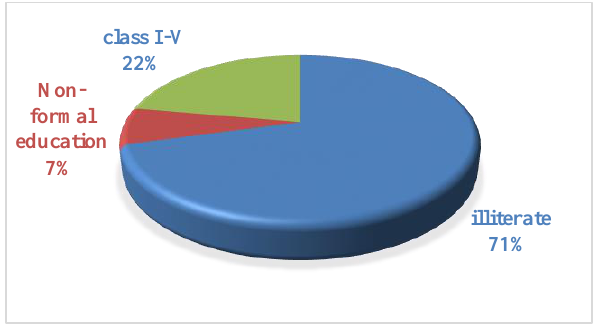
Fig-1: Distribution of injured children by mothers education, n=212 Fig-1 reveals the distribution of mother’s education. About 150(71%) were illiterate, 15 (7%) were non-formally educated and 47(22%) were class I-V learned.